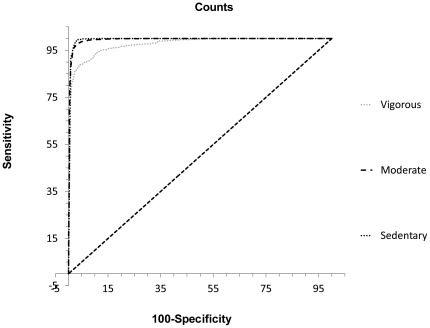
ROC curve for sedentary, moderate and vigorous.